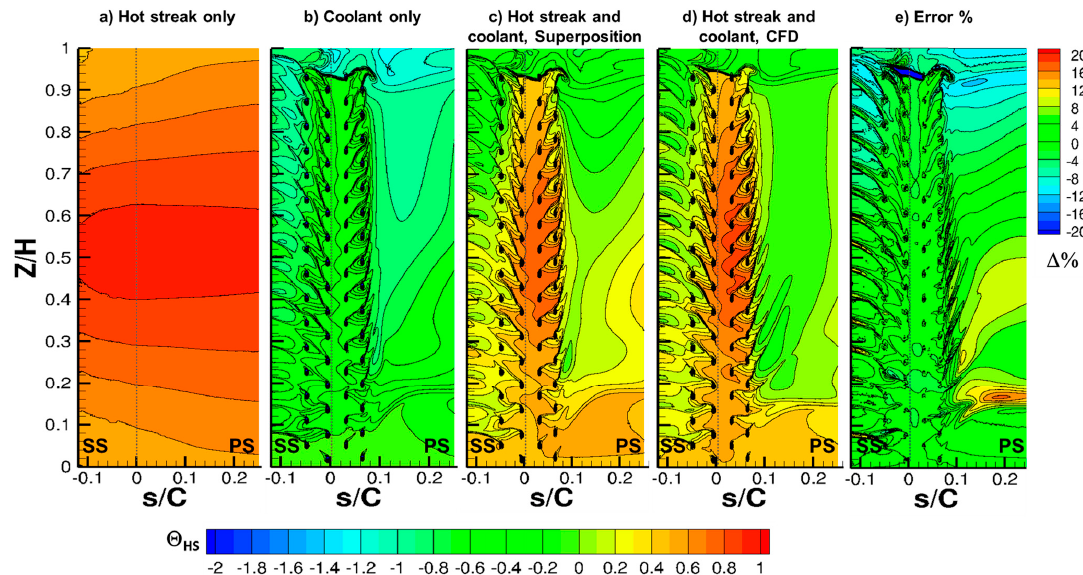
Figure 14. Comparison of predicted and superposition temperature ratio ( Θ HS ) for the vane-aligned hot streak, combined with showerhead blowing at BR = 3.0 ( MFR = 1.15%). ( a ) Hot streak only; ( b ) coolant only; ( c ) superposition of hot streak and coolant; ( d ) CFD modelling of hot streak and coolant; ( e ) error (%).